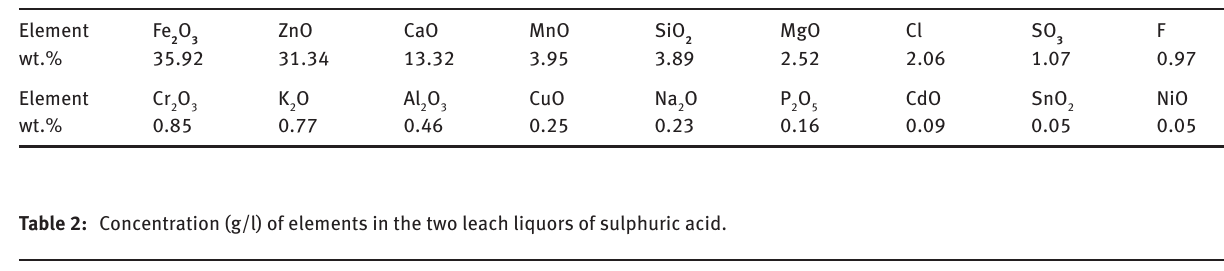
Table 2: Concentration (g/l) of elements in the two leach liquors of sulphuric acid. Element